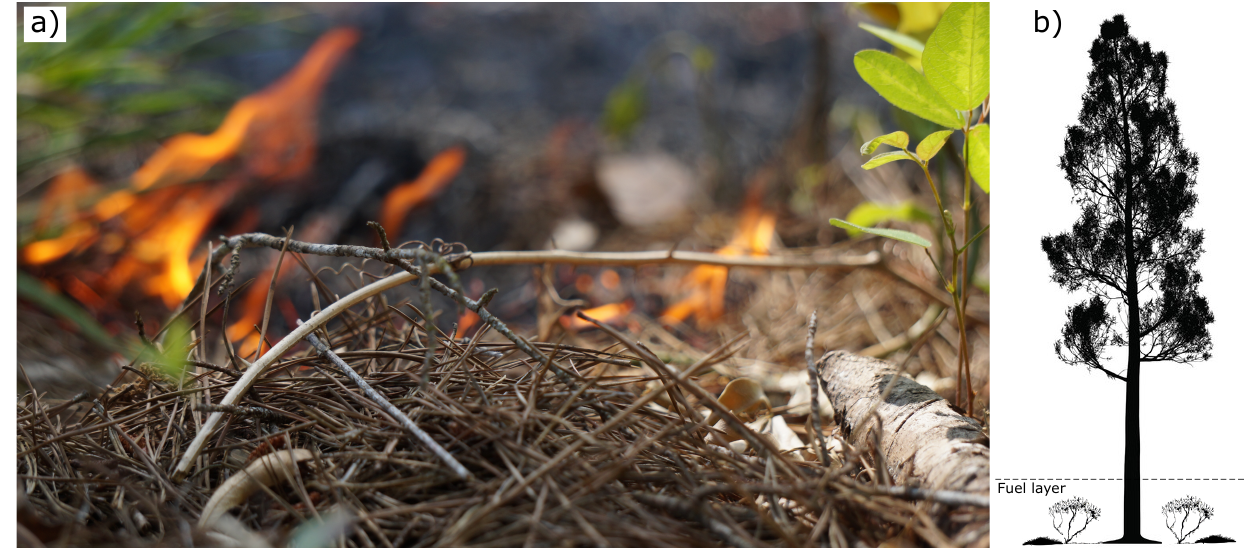
Figure 1. ( a ) A typical mixed fuel composition of the fuel layer in a pine forest, with prescribed fire in the background. ( b ) A schematic showing the vegetated fuel layer with respect to a typical pine